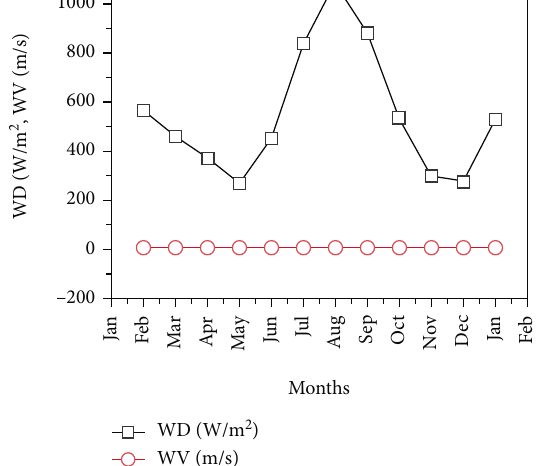
Figure 12: Wind power density distribution from 4 ° N to 14 ° N.